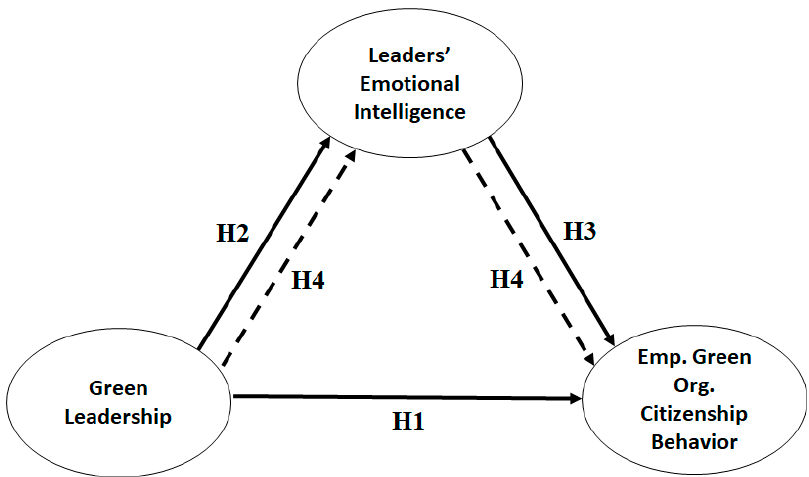
Figure 1. Theoretical